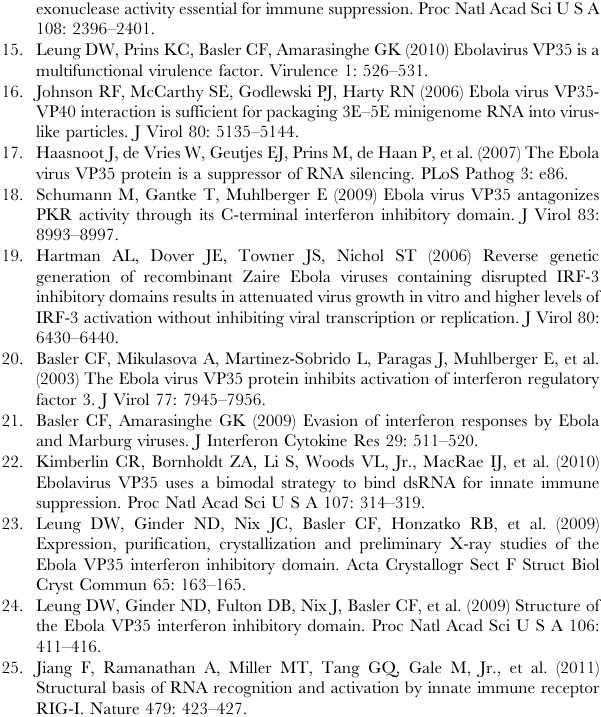
Figure S1 The conserved first basic patch in MARV VP35 RBD. (A) Cartoon representation of MARV VP35 RBD. Conserved residues are shown in ball and stick and colored orange. (B) Electrostatic surface representation of the RBD showing the basic patch with a limit of 6 3 k B T/e c . (TIF) Figure S2 The MARV VP35 RBD interface between adjacent monomers (A – shown in green, B-shown in yellow). This interaction buries a surface area of 340 A˚ 2 . A hydrogen bond between A302 and T219 (residues represented as sticks) is shown as a black dashed line. (TIF) Figure S3 Dot blot binding assay of MARV VP35 RBD containing an F228L point mutation (circles), or a shorter version of the RBD from which the final two residues were deleted (now containing residues 205–327; squares) compared to wild-type (triangles), binding to 18-bp blunt-ended dsRNA. (TIF)